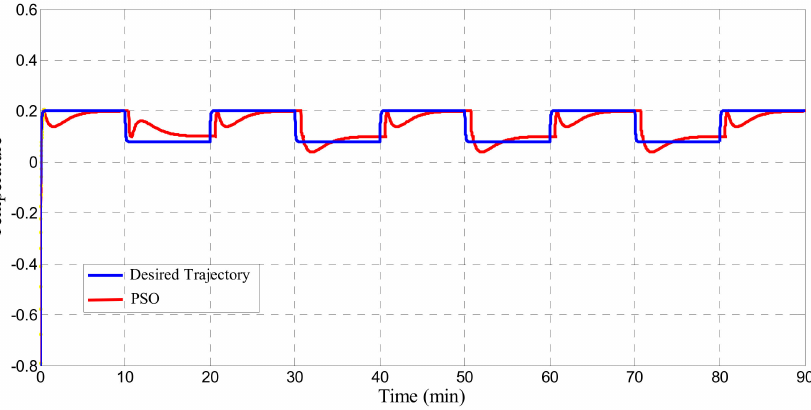
Figure 12. Desired trajectory and control PSO.